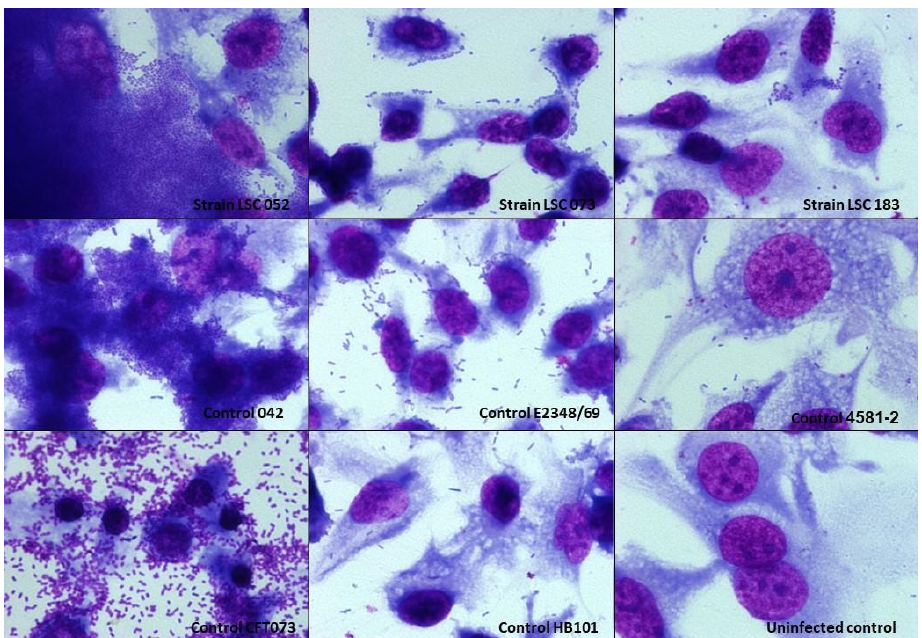
Figure 3. Interaction of hybrid uropathogenic Escherichia coli (UPEC) strains with T24 cells of bladder origin. The ability of hybrid UPEC strains to interact with human bladder cells was evaluated in assays with an incubation period of 3 h, at 37 °C, without D-mannose, using a multiplicity of infection of 10. The preparations were stained with May-Grünwald/Giemsa and observed under light microscopy (magnification ×1000). Hybrid UPEC/enteroaggregative E. coli (EAEC) strain (LSC 052) and hybrid UPEC/atypical enteropathogenic E. coli (aEPEC) strains (LSC 073 and LSC 183) interacted with bladder cells at different intensities. E. coli strains used as controls: 042 (prototype EAEC); E2348/69 (prototype typical EPEC); 4581-2 (atypical EPEC); CFT073 (prototype UPEC); HB101 strain (non-adherent E. coli K-12-derived laboratory strain).